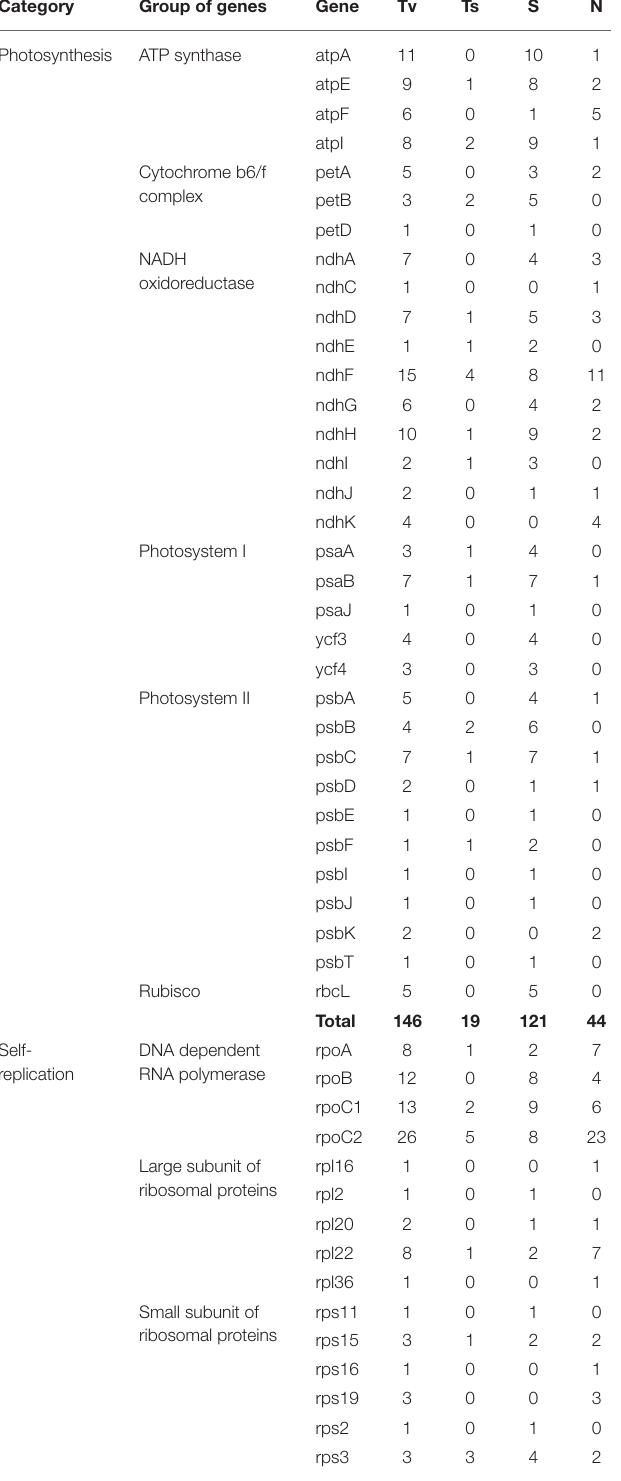
TABLE 3 | Comparisons of mutations, including the number of transversions (Tv), transitions (Ts), synonymous (S), and non-synonymous (N) substitutions per protein-coding genes across the plastomes of the five Kalanchoe species. Category Group of genes Gene Photosynthesis